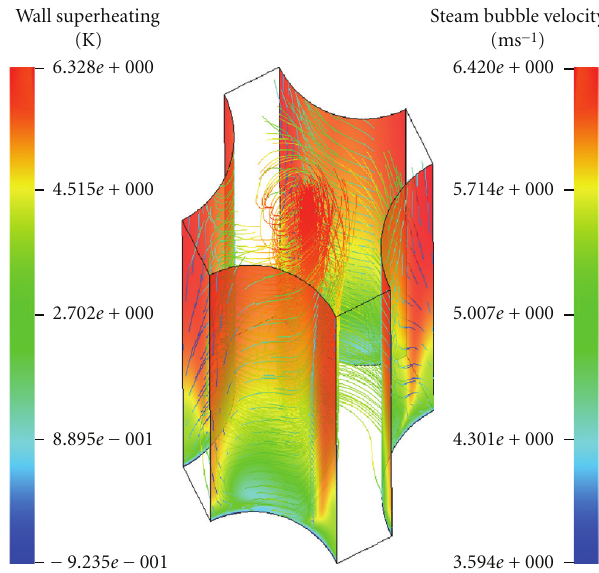
Figure 12: Hot channel vapour flow streamlines and rod surface